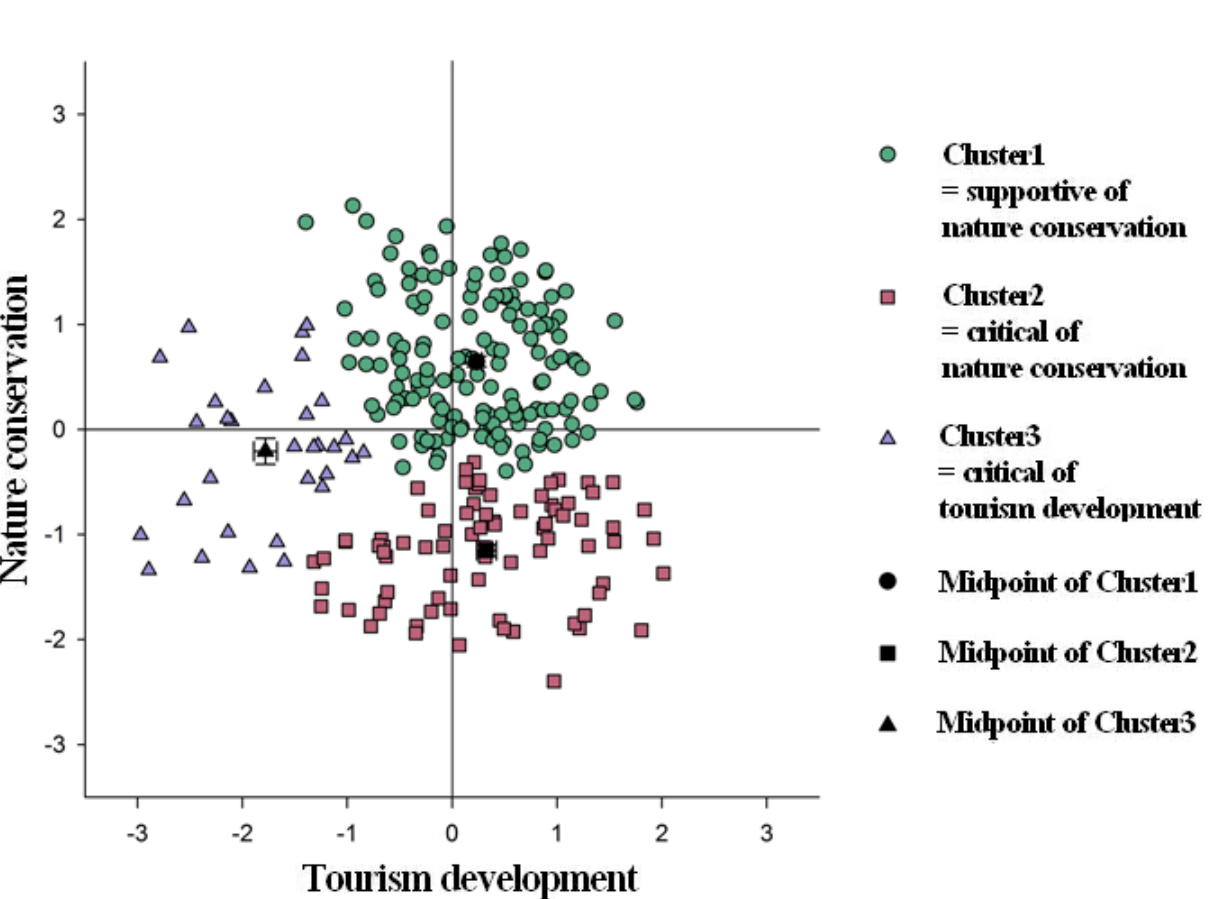
Fig. 3 . Biplot of the hierarchical cluster analysis. Midpoints present arithmetic means calculated from individual observations. Standard errors are seldom visible because of low